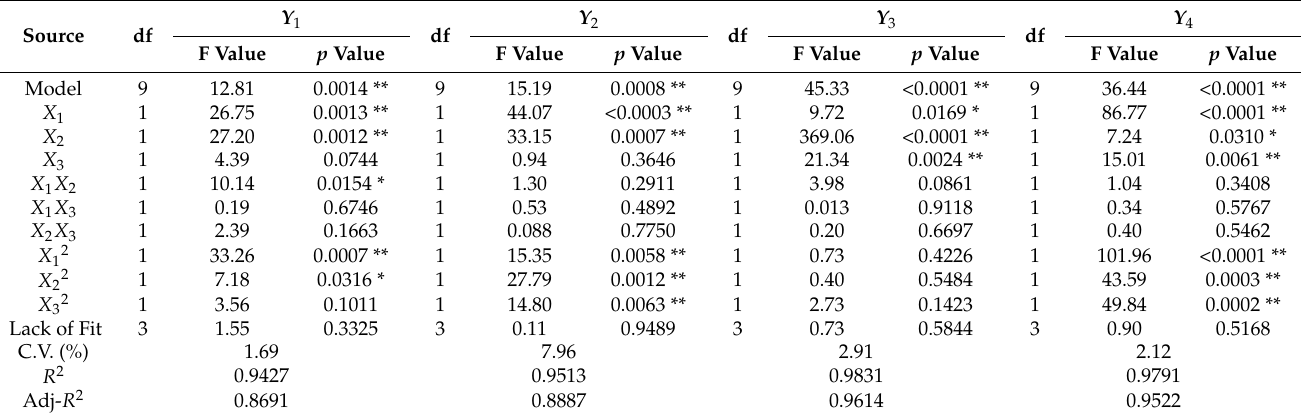
Table 5. ANOVA for respective regression models and model